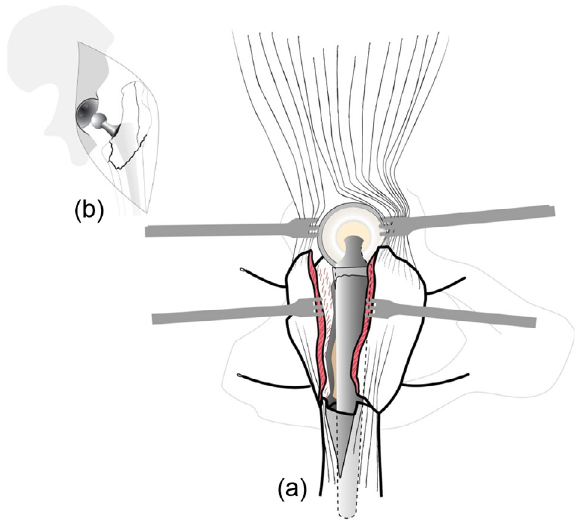
Figure 9. (a) Stem and DMC after reduction, (b) before reduction.